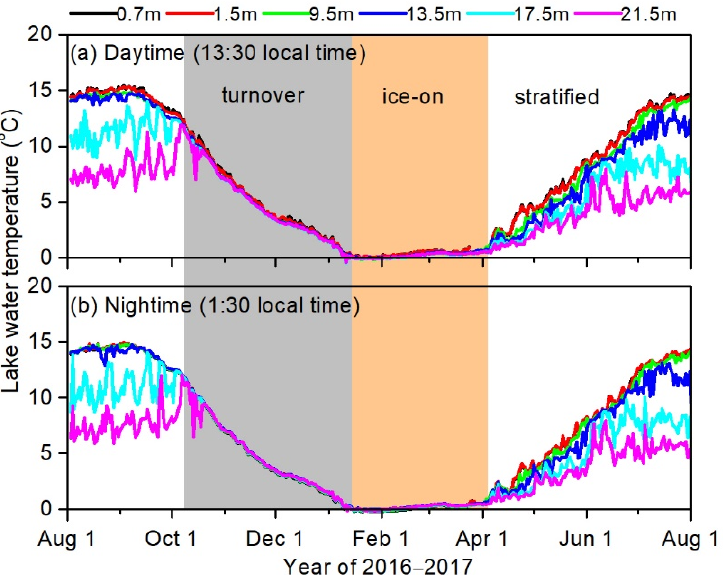
Figure 4. Observed annual cycle of thermal structure of Lake Zhari Namco in the year of 2016–2017. Water temperature was measured at five depths.